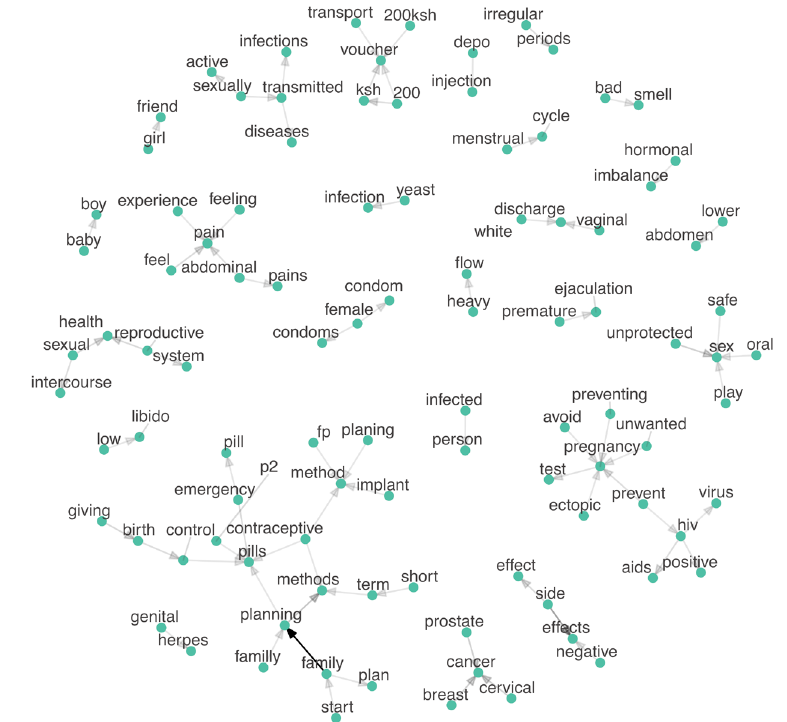
Figure 7. Network graph of most frequent English bigrams. The points (nodes) represent words, the lines (edges) represent the most frequent connections between words, and the arrows indicate the temporal ordering of the words. KSH, Kenyan Shillings; p2, Postinor-2; HIV, human immunodeficiency virus; AIDS, acquired immunodeficiency syndrome; FP, family planning